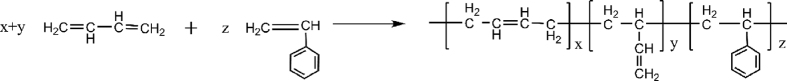
Molecular structure of SBR.